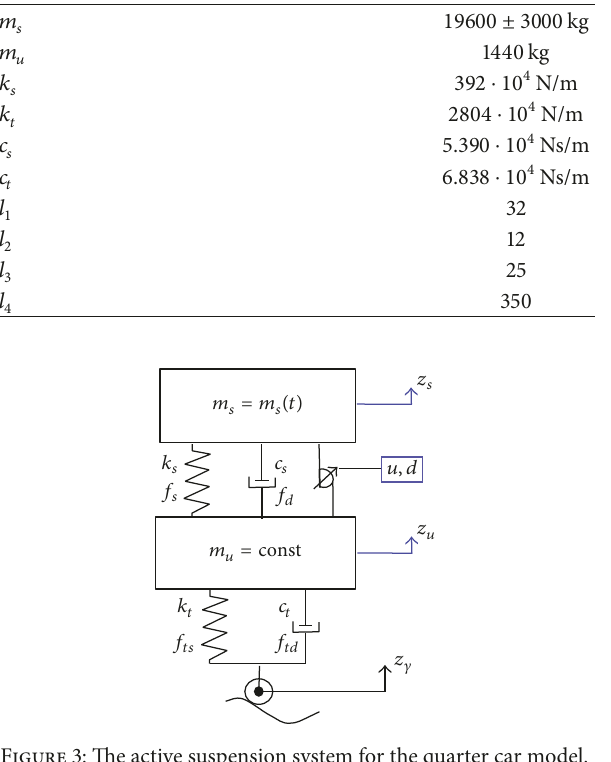
Figure 3: The active suspension system for the quarter car model.